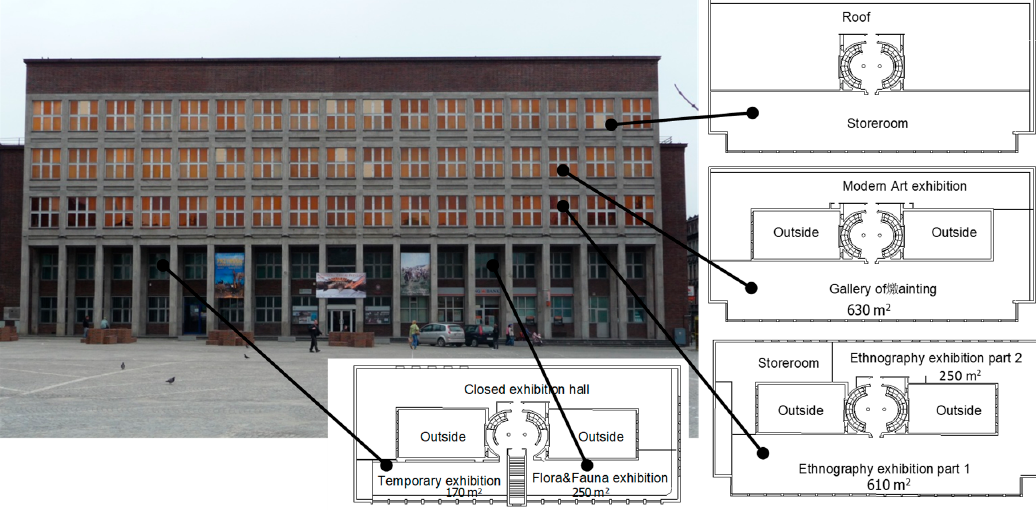
Figure 1. The museum building view (west site) and the floor plans.